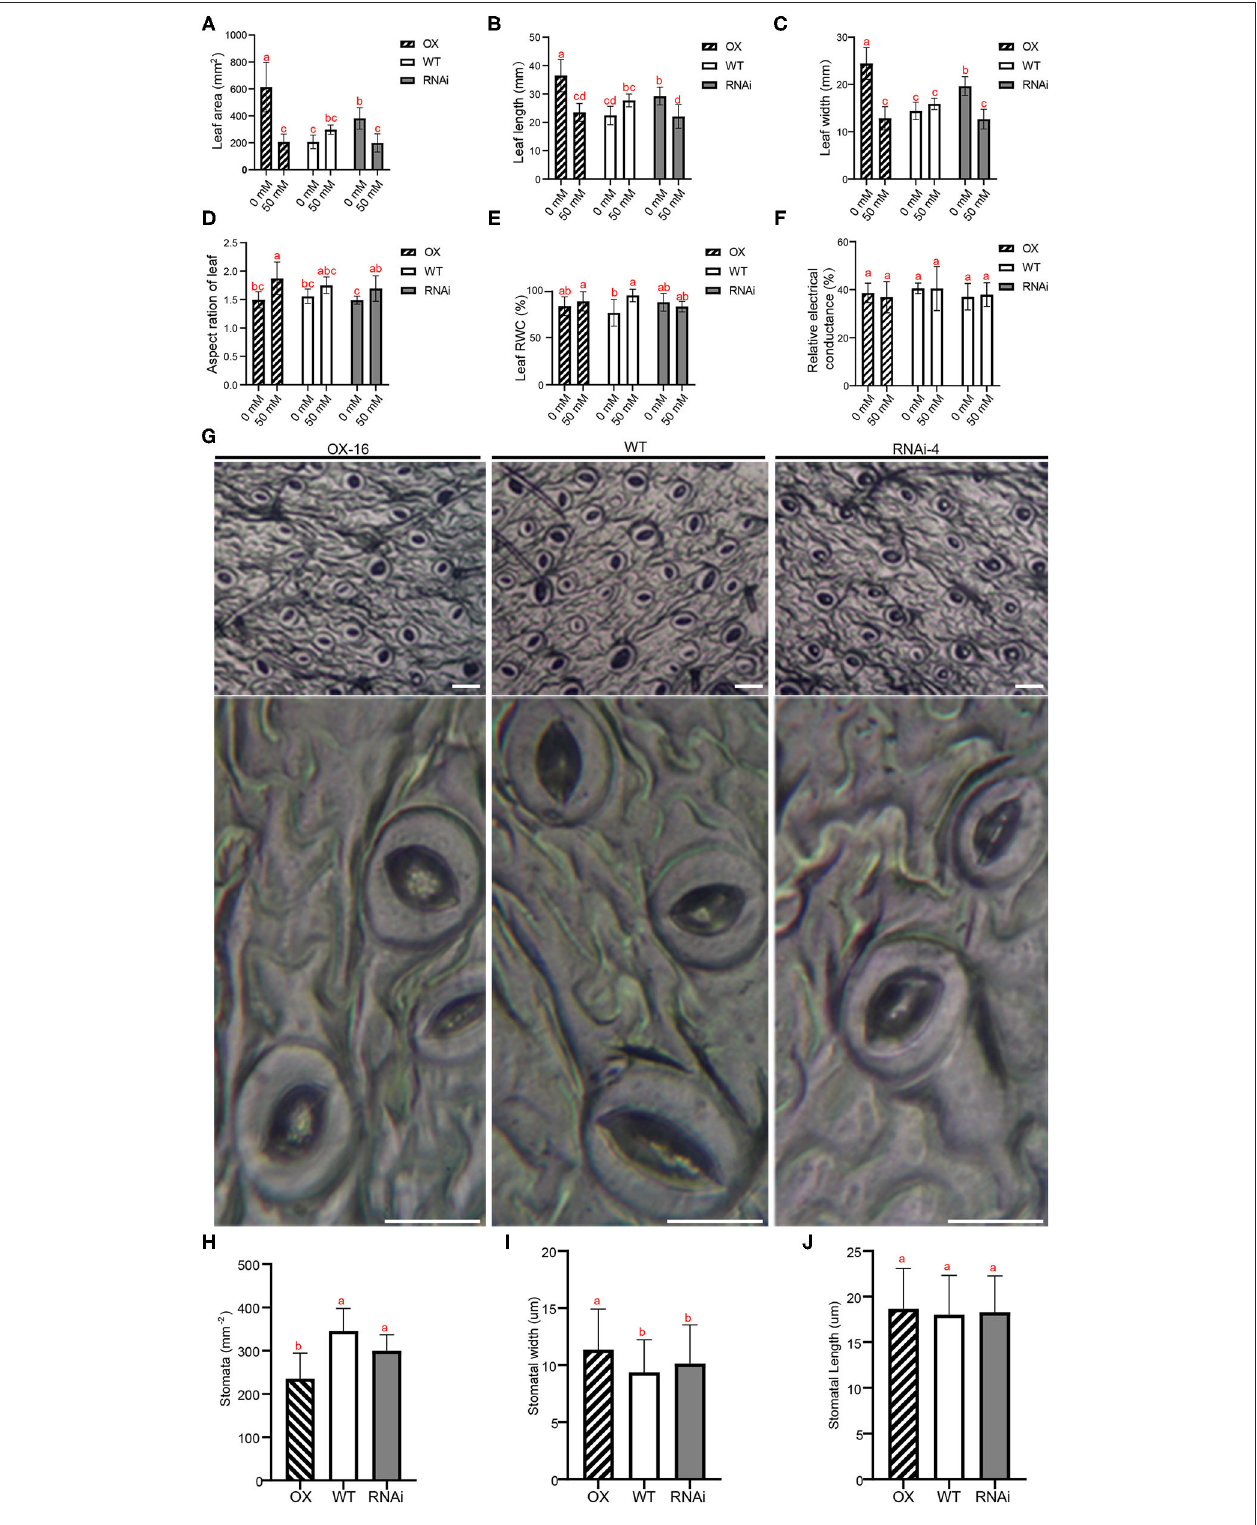
FIGURE 4 | PagERF16 decreased stomatal density and increased stomatal width. (A–D) Represent area, length, width, and aspect ratio of the second mature leaf. (E) Relative water content of the second mature leaf. (F) Relative electrical conductance of the second leaf. (G) Scanning electron micrograph of the abaxial leaf epidermis. Bars, 20 µ m. (H–J) show the stomatal density, width, and length. The plot represents the mean ± SD of six plants per line. Three OX or RNAi lines serve as three biological repeats. Different lowercases indicate significant differences among samples ( p ≤ 0.05).